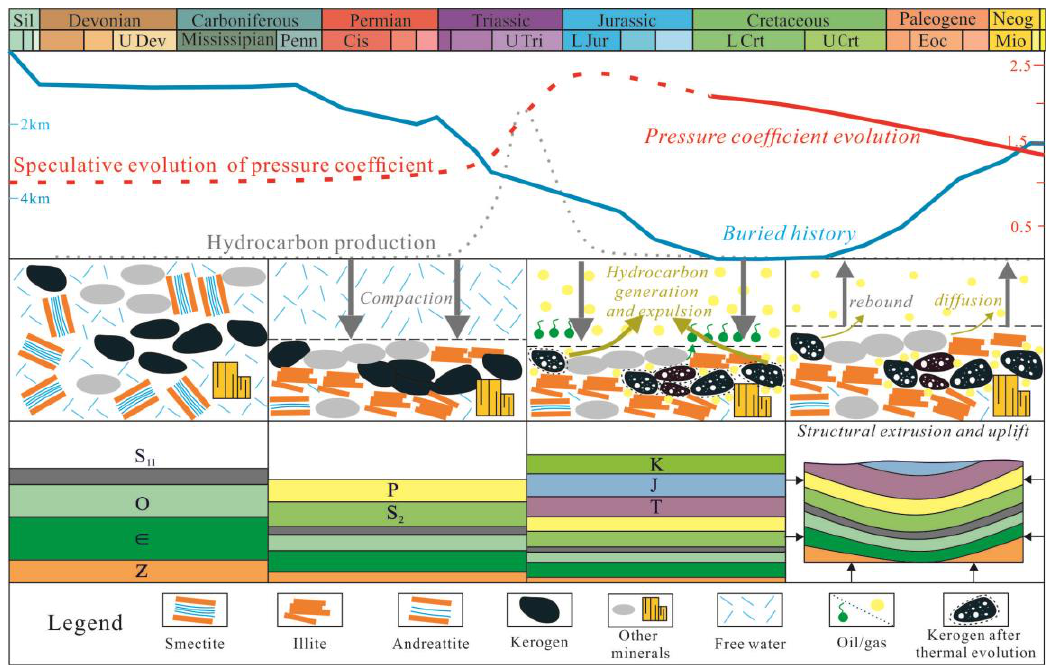
Figure 17. Overpressure evolution of the O 3 w – S 1 l shales in the CN well. The upper half of the figure represents the burial, reservoir pressure and hydrocarbon production histories of the O 3 w – S 1 l shales in the CN well, assuming that the initial pressure coefficient is 2.0. The lower half of the figure represents the four stages of shale gas accumulation evolution of the CN well.